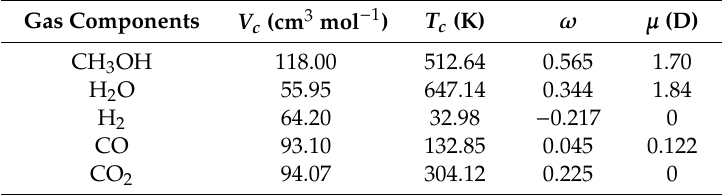
Table 1. Basic constants values for the calculation of viscosity of